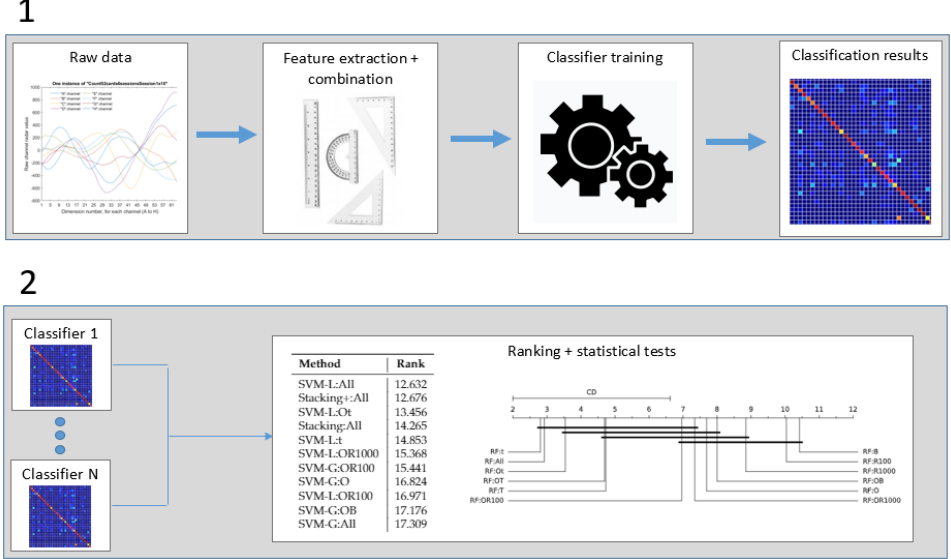
Figure 3. Flow chart describing the general data processing pipeline, divided into two